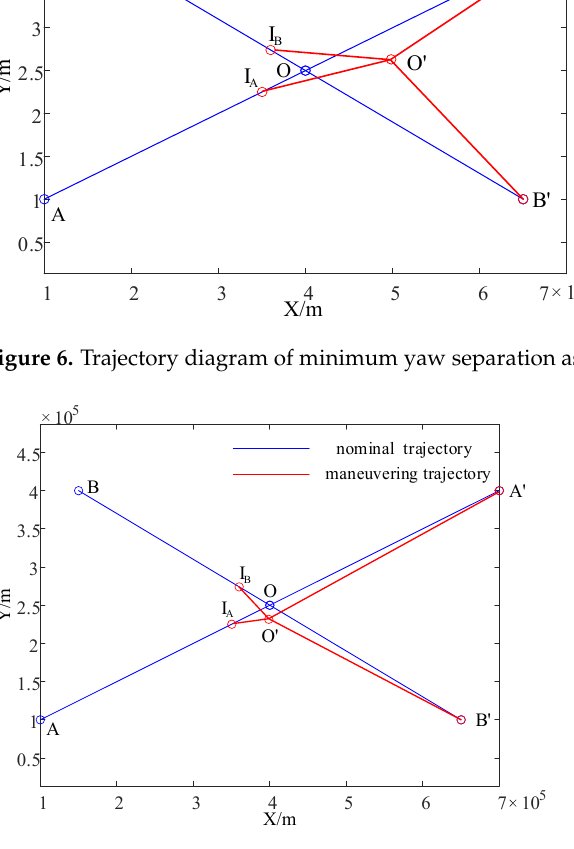
Figure 7. Trajectory diagram of minimum maneuver time separation assurance strategy.